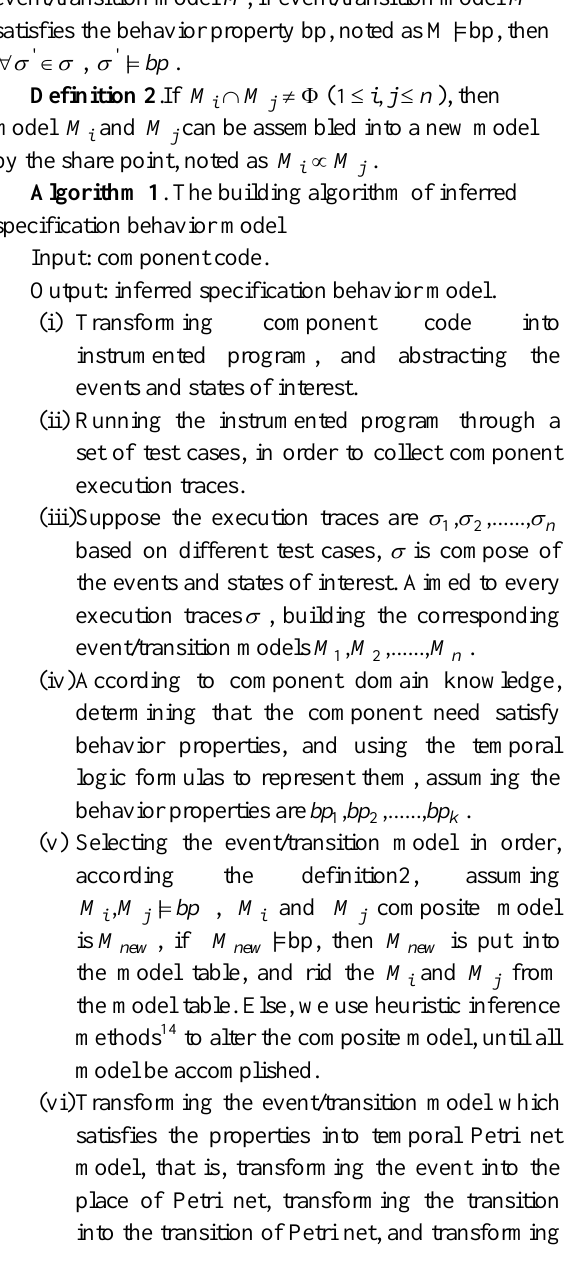
Algorithm 1 . The building algorithm of inferred specification behavior